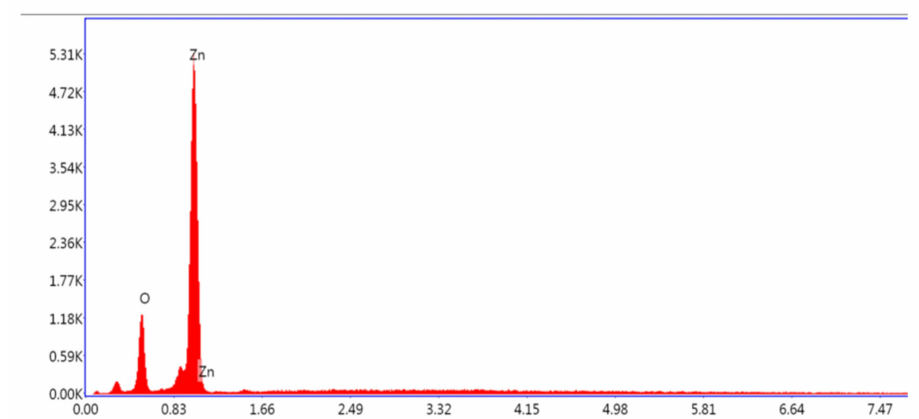
Figure 3. Energy-dispersive X-ray (EDX) spectrum of green-synthesized ZnO NPs.